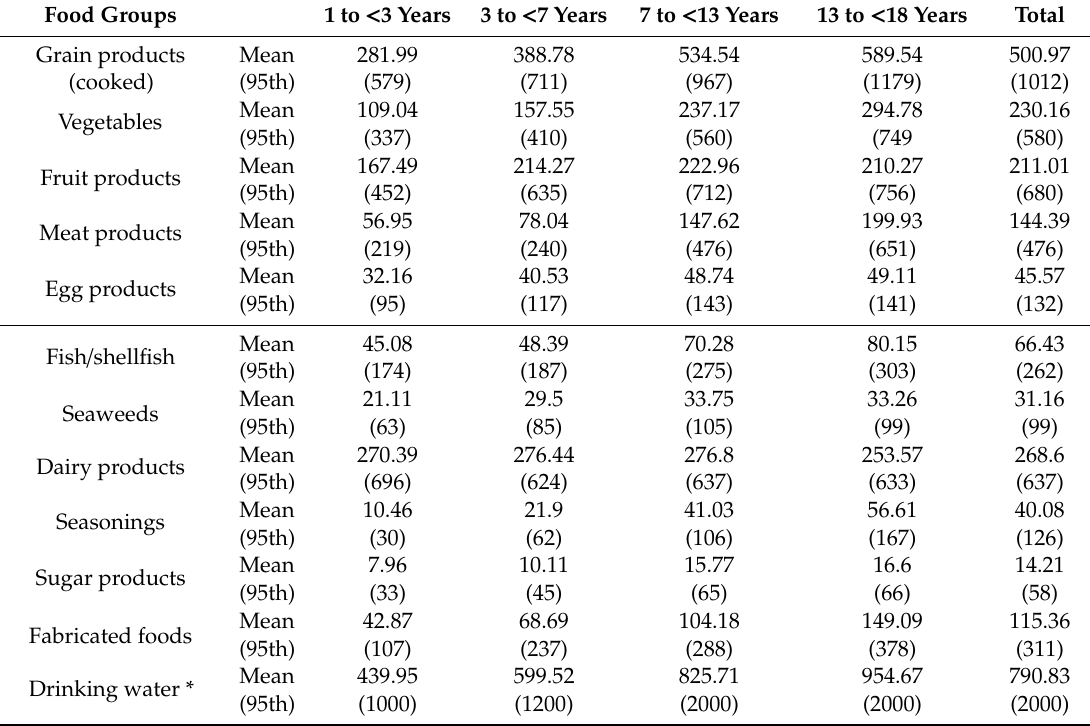
Table 6. Average and 95th percentile values of consumer-only dietary intake (g / day) by age group.